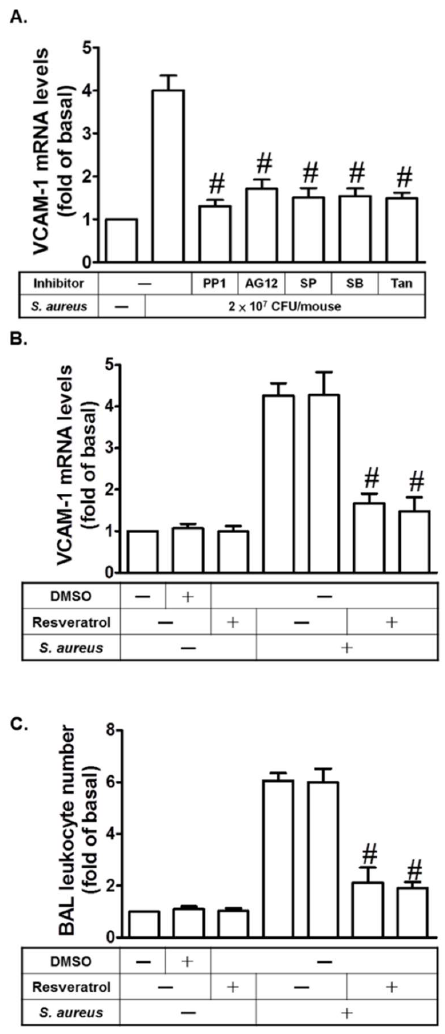
Figure 7. Resveratrol inhibits S. aureus -induced VCAM-1 expression in the lungs of mice. ( A ) Mice were intraperitoneal given one dose of PP1, AG1296, SP600125, SB202190, or Tanshinone IIA for 2 h prior to S. aureus (2 × 10 7 CFU/mouse) treatment, and sacrificed after 24 h. Preparation of lung tissues was analyzed by real-time PCR to determine the levels of VCAM-1 mRNA. ( B ) Mice were intraperitoneal given one dose of resveratrol for 24 h prior to S. aureus (2 × 10 7 CFU/mouse) treatment, and sacrificed after 24 h. Preparation of lung tissues was analyzed by real-time PCR to determine the levels of VCAM-1 mRNA. ( C ) Mice were intraperitoneal given one dose of resveratrol for 24 h prior to S. aureus (2 × 10 7 CFU/mouse) treatment, and sacrificed after 24 h. Bronchoalveolar lavage (BAL) fluid was acquired and leukocyte count was determined. n = 4–5, # p < 0.01, as compared with the mice exposed to S. aureus alone.